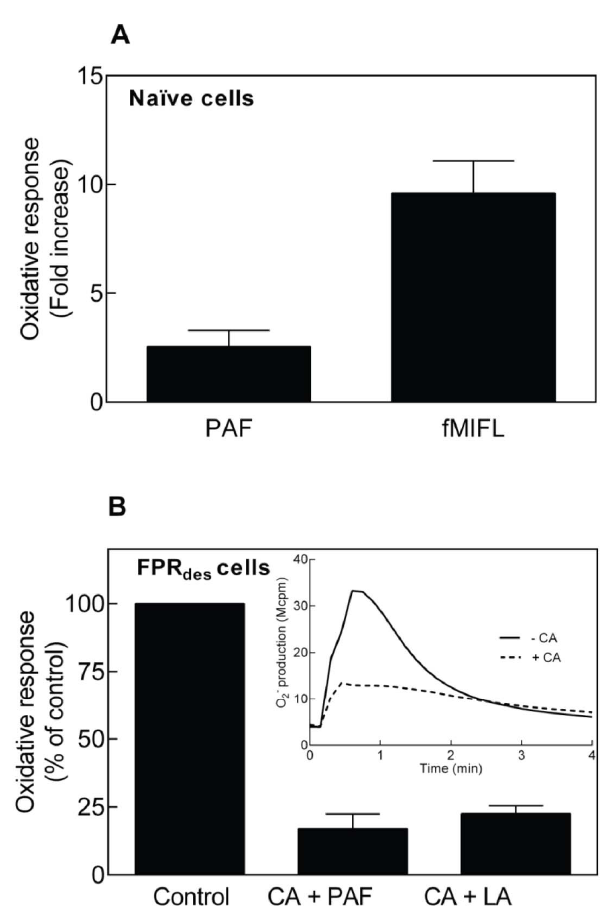
Figure 4. Phosphatase inhibition by CalyculinA has both inhibitory and priming effects on the neutrophil NADPH- oxidase response. ( A ) Human neutrophils were incubated without or with CalyculinA (CA; 60 nM) at 37 u C for 10 min prior to stimulation with PAF (100 nM) or fMIFL (0.1 nM), and the release of superoxide anions was recorded. The graph shows ratios of superoxide production induced by PAF or fMLF between samples with and without calyculin A (fold increase, mean 6 SEM; n=5). ( B ) FPR1 des neutrophils (desensitized with 0.1 nM fMIFL) were incubated at 37 u C for 10 min without (control and inset, solid line) or with CalyculinA (CA, 50 nM; inset, broken line). The cells were then stimulated with PAF (100 nM) or latrunculin A (100 ng/ml final concentration) and the release of superoxide anions was recorded. A representative experiment for PAF stimulation is shown in the inset. The stimulus-induced responses in the CalyculinA treated FPR1 des neutrophils are expressed as percent of non-treated controls and is given as means 6 SEM